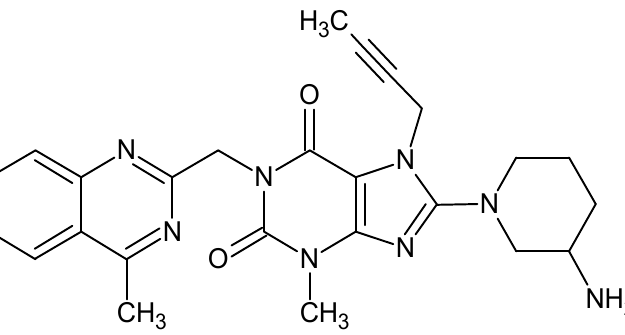
Figure 1. Chemical structure of linagliptin (LINA).